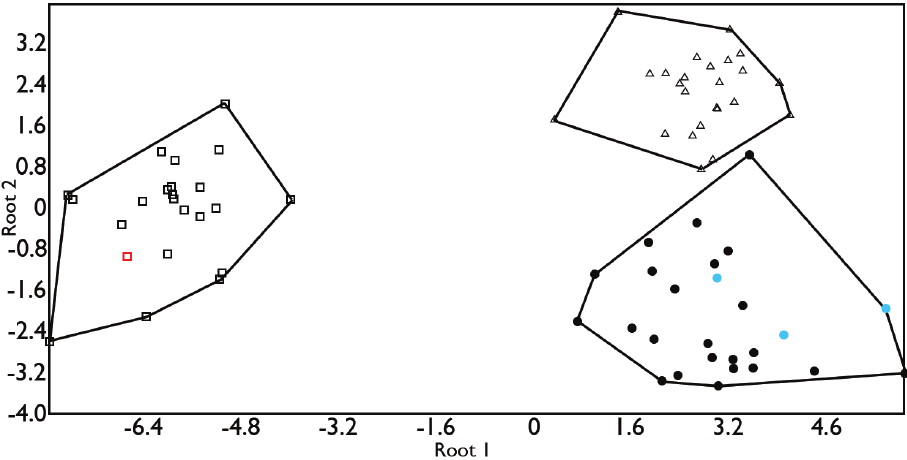
Figure 4. Ordination diagram from the GDA analysis of the morphological data for males. Circles represent specimens from Tamaulipas, Hidalgo, and northern and central Veracruz; triangles represent individuals from southern Veracruz and western Tabasco; squares represent individuals from the YP. Blue circles indicate specimens collected near the type locality of Anolis sericeus . The red square indicates the syntype of A. ustus .